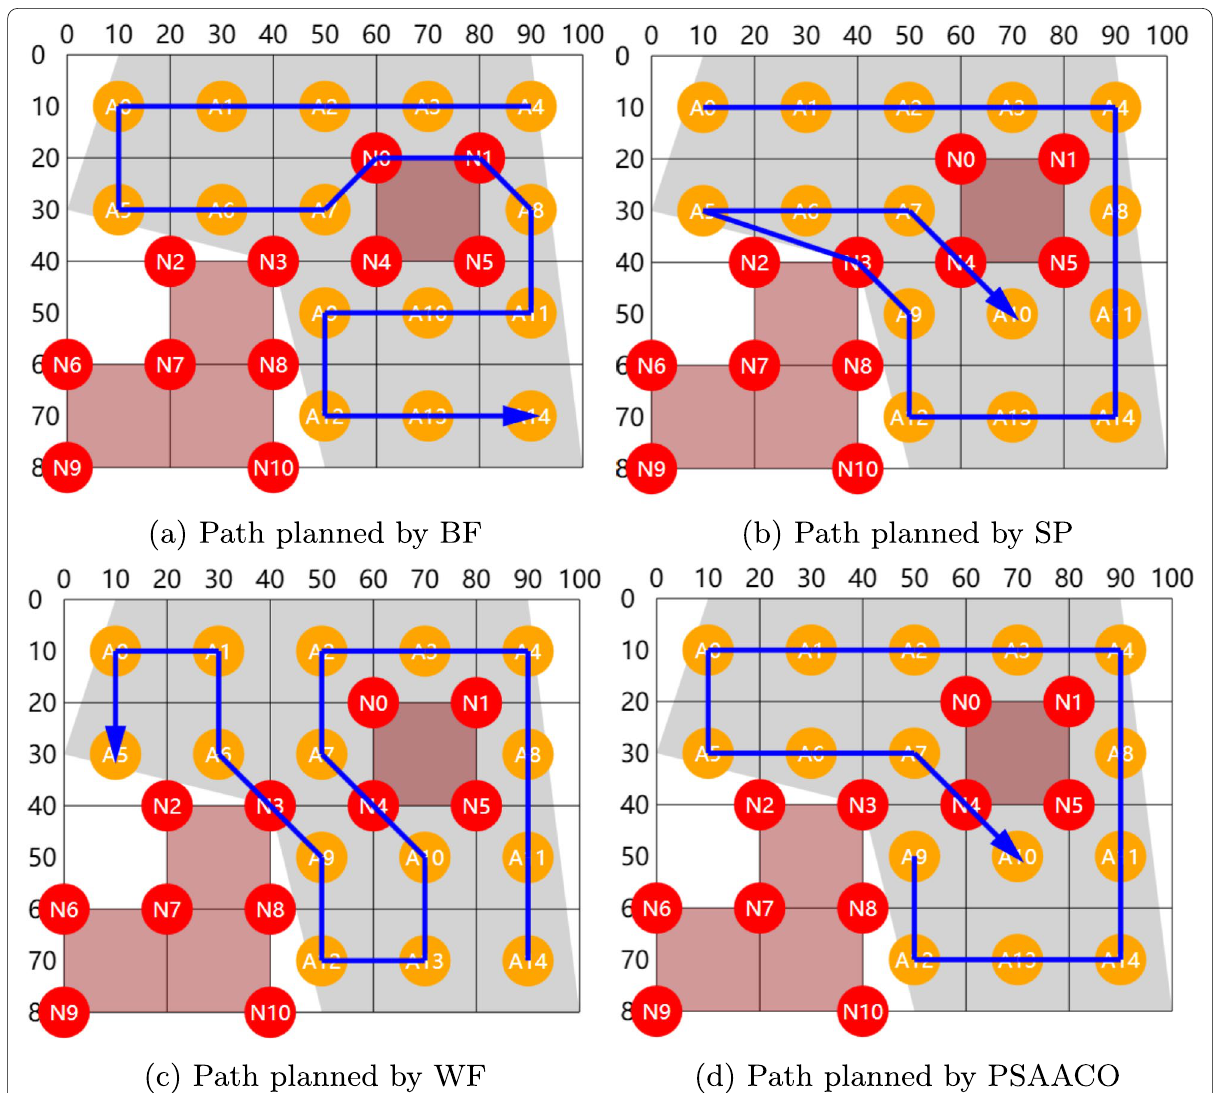
Fig. 6 Performance comparison experiment on CPP